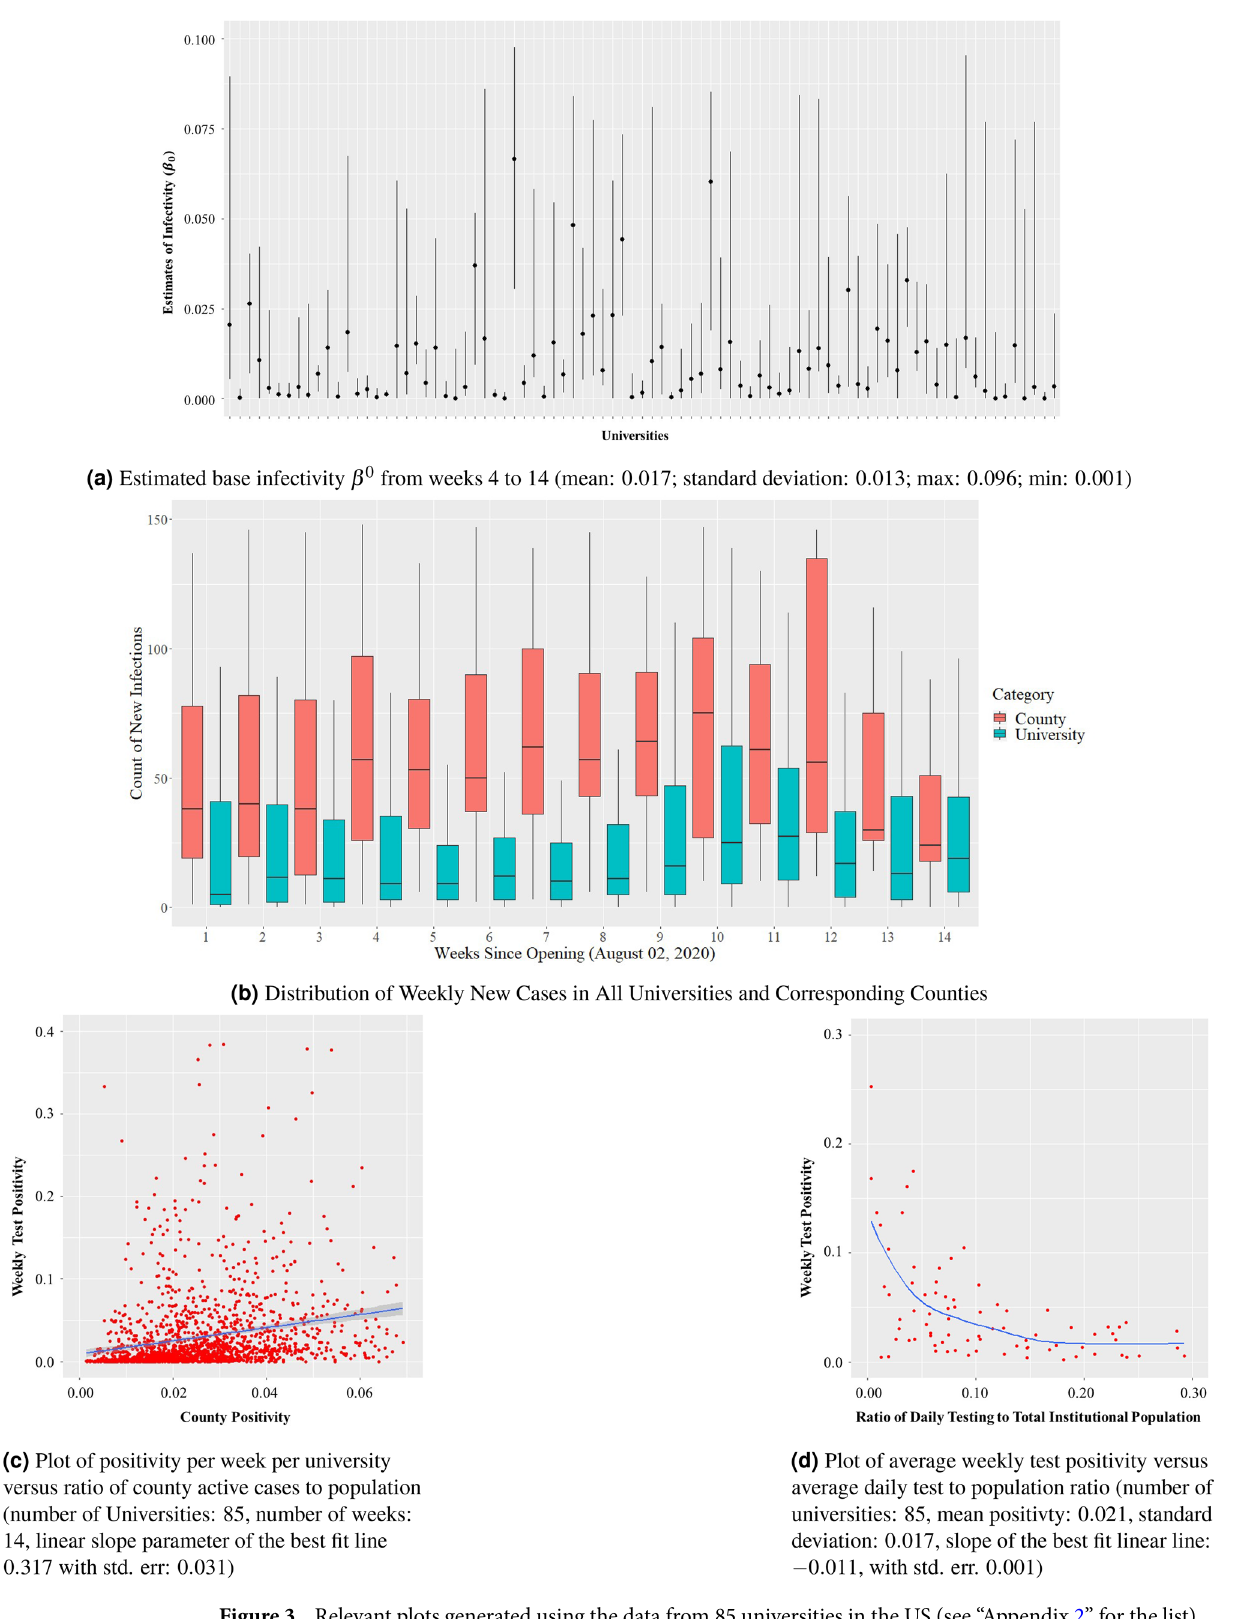
Figure 3. Relevant plots generated using the data from 85 universities in the US (see “Appendix 2” for the